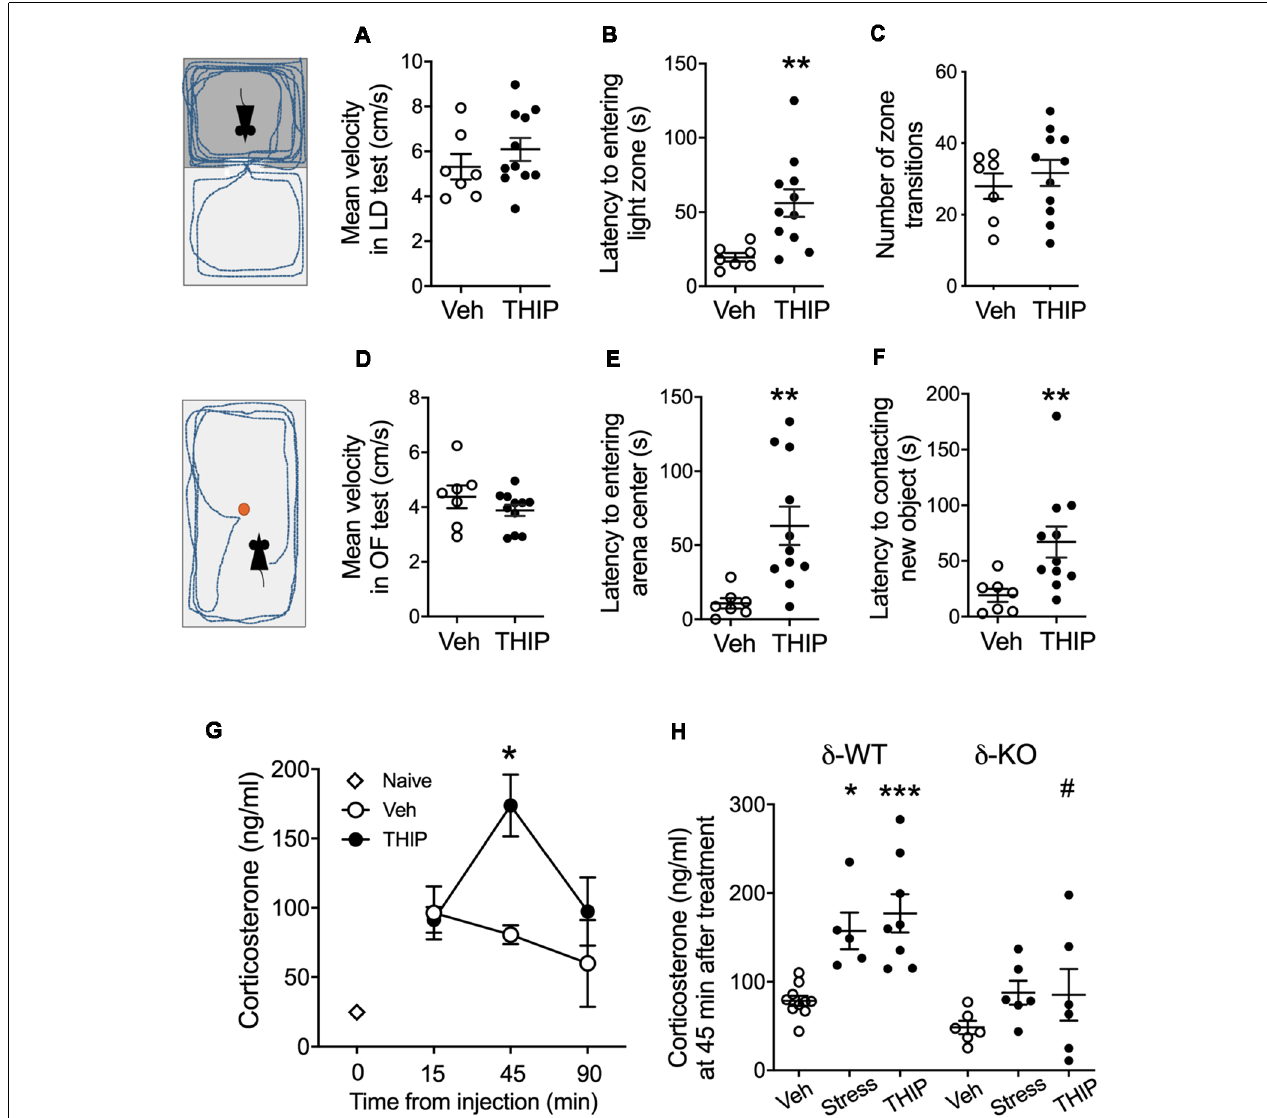
FIGURE 1 | THIP acutely promoted anxiety-like behavior associated with increased plasma corticosterone levels in adult C57BL/6J mice. Mice were treated with vehicle or THIP (6 mg/kg, i.p.) 2 h before assessing their behavior in light-dark exploration (A–C) and open field (D–F) tests; n = 7 and 11 mice treated with saline vehicle and THIP, respectively; ∗∗ p < 0.01 ( t -test). (G) Time course of the effect of THIP treatment on plasma corticosterone level in adult C57BL/6J mice. Points are means ± SEM for naïve mice n = 4; vehicle-treated mice at 15 min n = 6, at 45 min n = 6, at 90 min n = 5; THIP-treated mice at 15 min n = 6, at 45 min n = 8, at 90 min n = 6. ∗ p < 0.05 for the difference from vehicle (Kruskal-Wallis test). (H) Corticosterone levels at 45 min after treatments with vehicle, THIP and acute swimming stress in δ -WT and δ -KO mice. Basal corticosterone levels were not significantly different between δ -WT and δ -KO mice ( p = 0.5). In contrast, THIP treatment and acute stress increased corticosterone levels in δ -WT mice ( p < 0.05), but not in δ -KO mice ( p > 0.05). Scatter plots with means ± SEM, n = 6–10 mice per group, ∗ p < 0.05, ∗∗∗ p < 0.001 for difference between treatments within the same genotype; # p < 0.01 for the difference between genotypes after the same treatment [analysis of variance (ANOVA) with Bonferroni